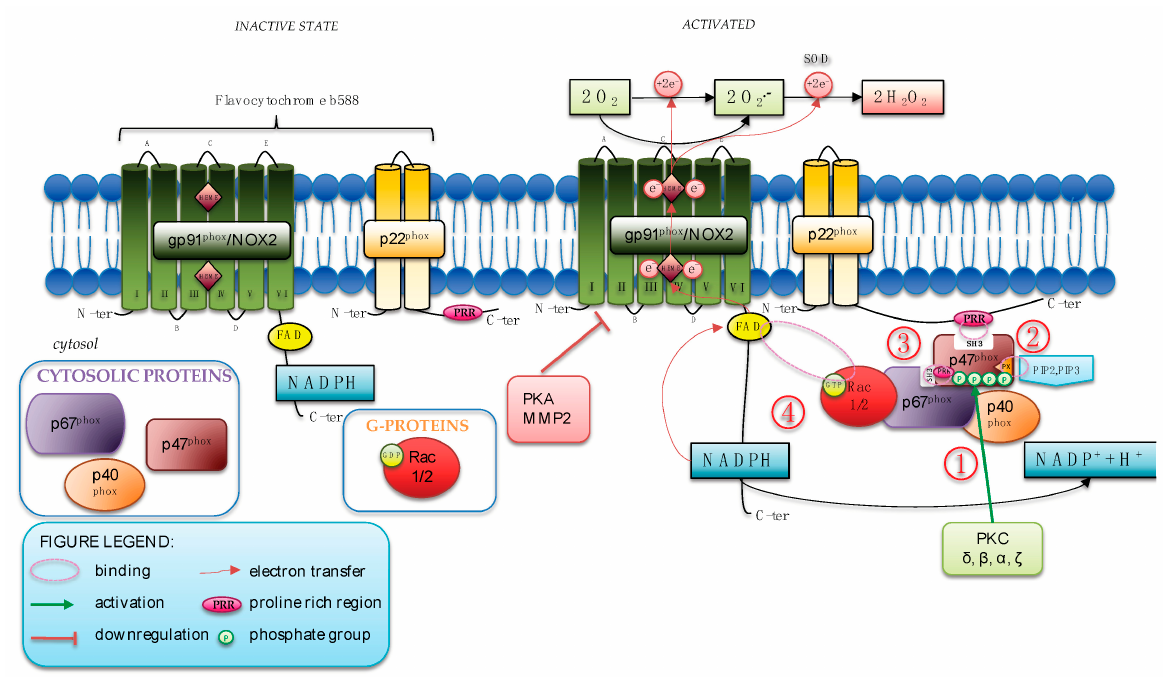
Figure 1. NOX2 activation and regulation. (1) When activated, PKC phosphorylates Ser304, Ser315, Ser320, and Ser328 of p47 phox ; (2) the phosphorylation of p47 phox uncovers its N-terminal SH3 domain that then binds the proline-rich region (PRR) in p22 phox . The PX domain of p47 phox binds the products of PI3K; (3) the activation of GTPase Rac2 mediates the translocation of p67 phox , which associates with p47 phox to the cytochrome; (4) Rac2 directly binds to the flavocytochrome favoring the initial steps of the electron transfer reaction.